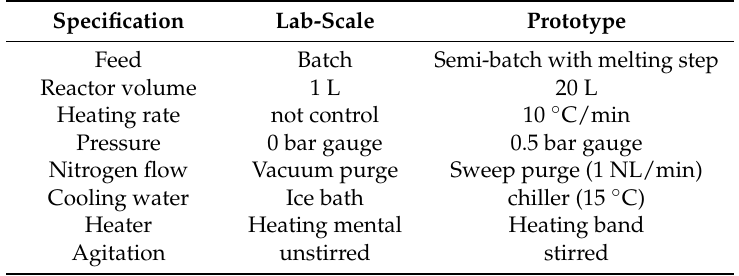
Table 1. Specification of process conditions at lab-scale and prototype-scale.